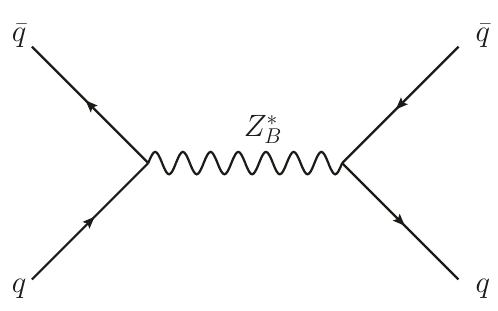
Figure 11 . Di-quark production